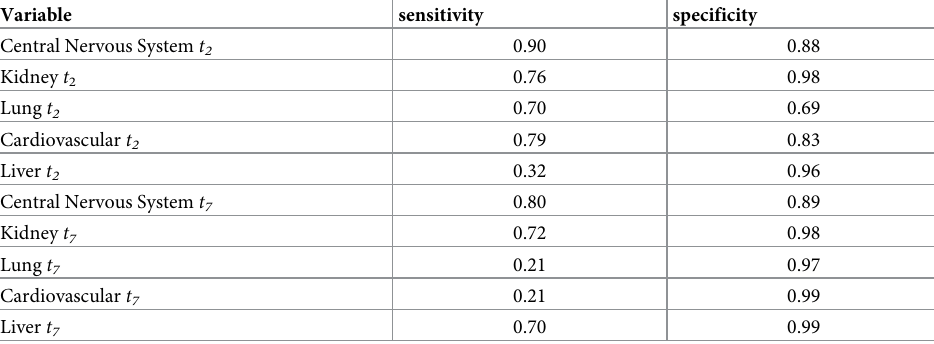
Table 2. The sensitivity and specificity of the final network prediction tested with the k -fold cross-validation